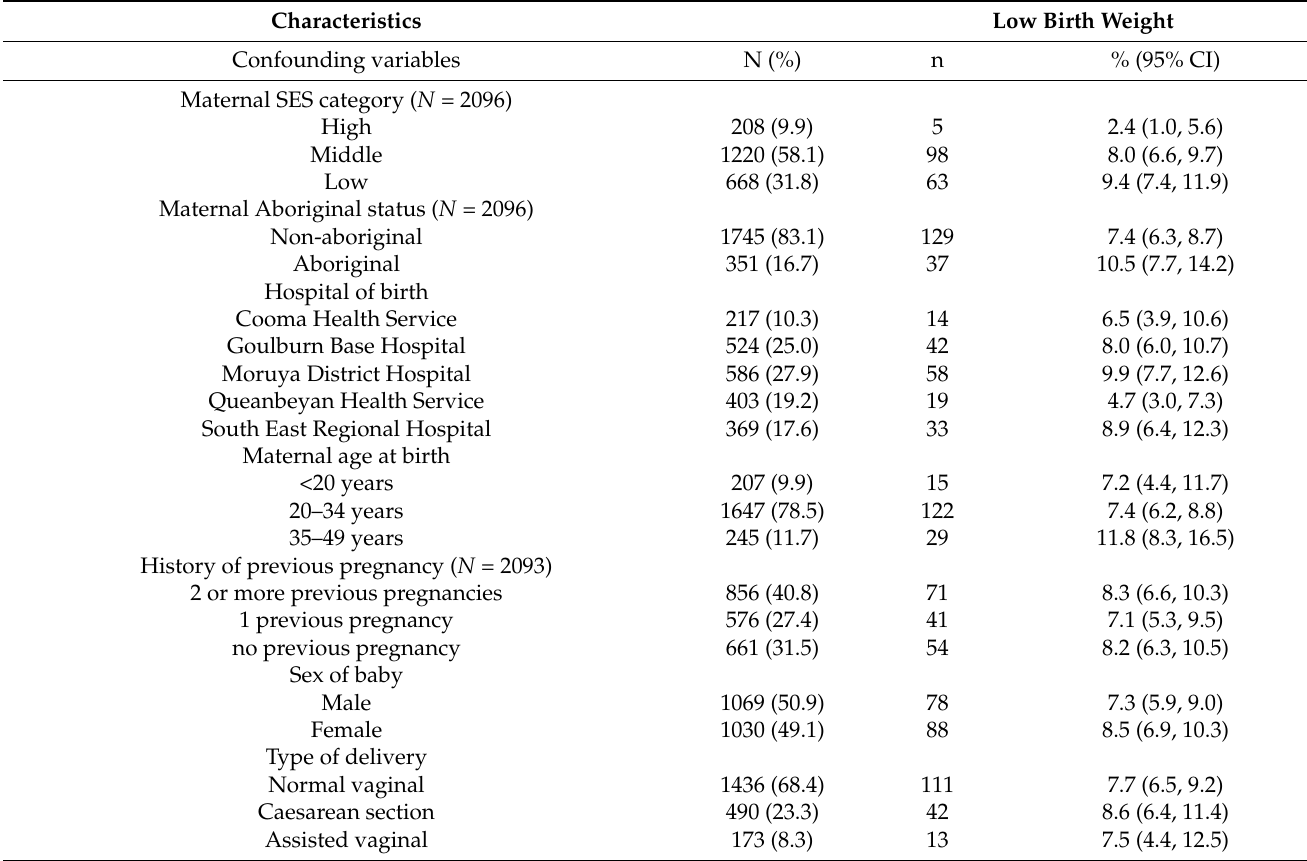
Table 1. Characteristics of the study population, number of babies with low birth weight, and percentage with 95% confi- dence interval (CI) in SNSWLHD ( N = 2099).